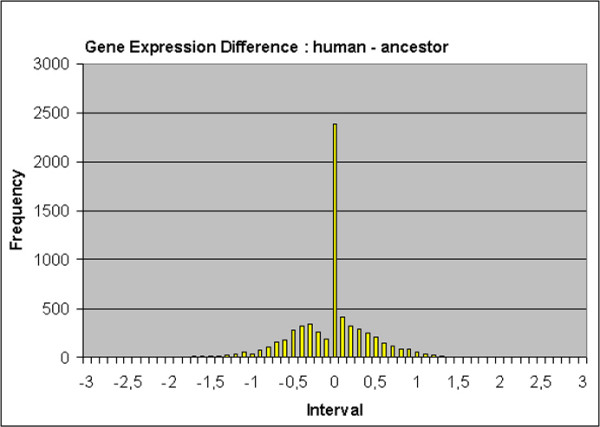
The distribution of gene expression values from Enard et al. [7] obtained with phyrex is shown for the lineage leading from the last common ancestor of human and chimpanzee to human.